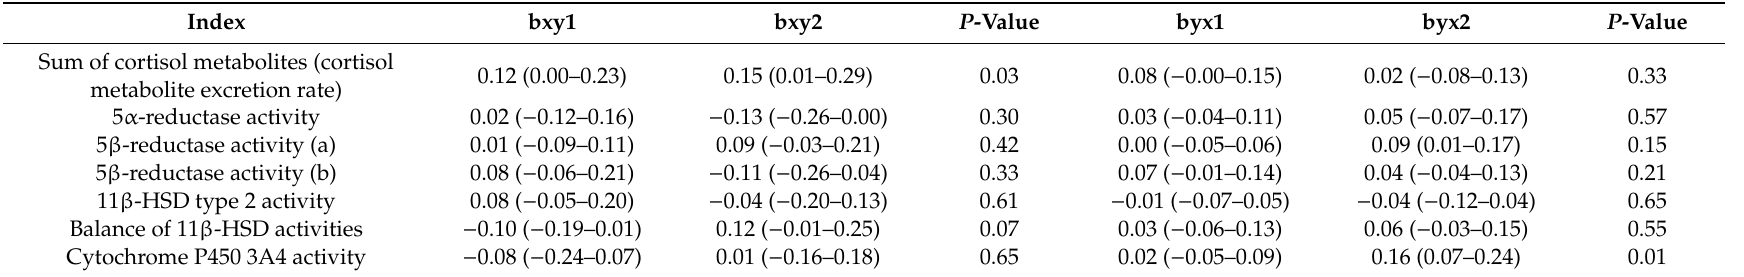
Table 3. The relation between BMI and cortisol